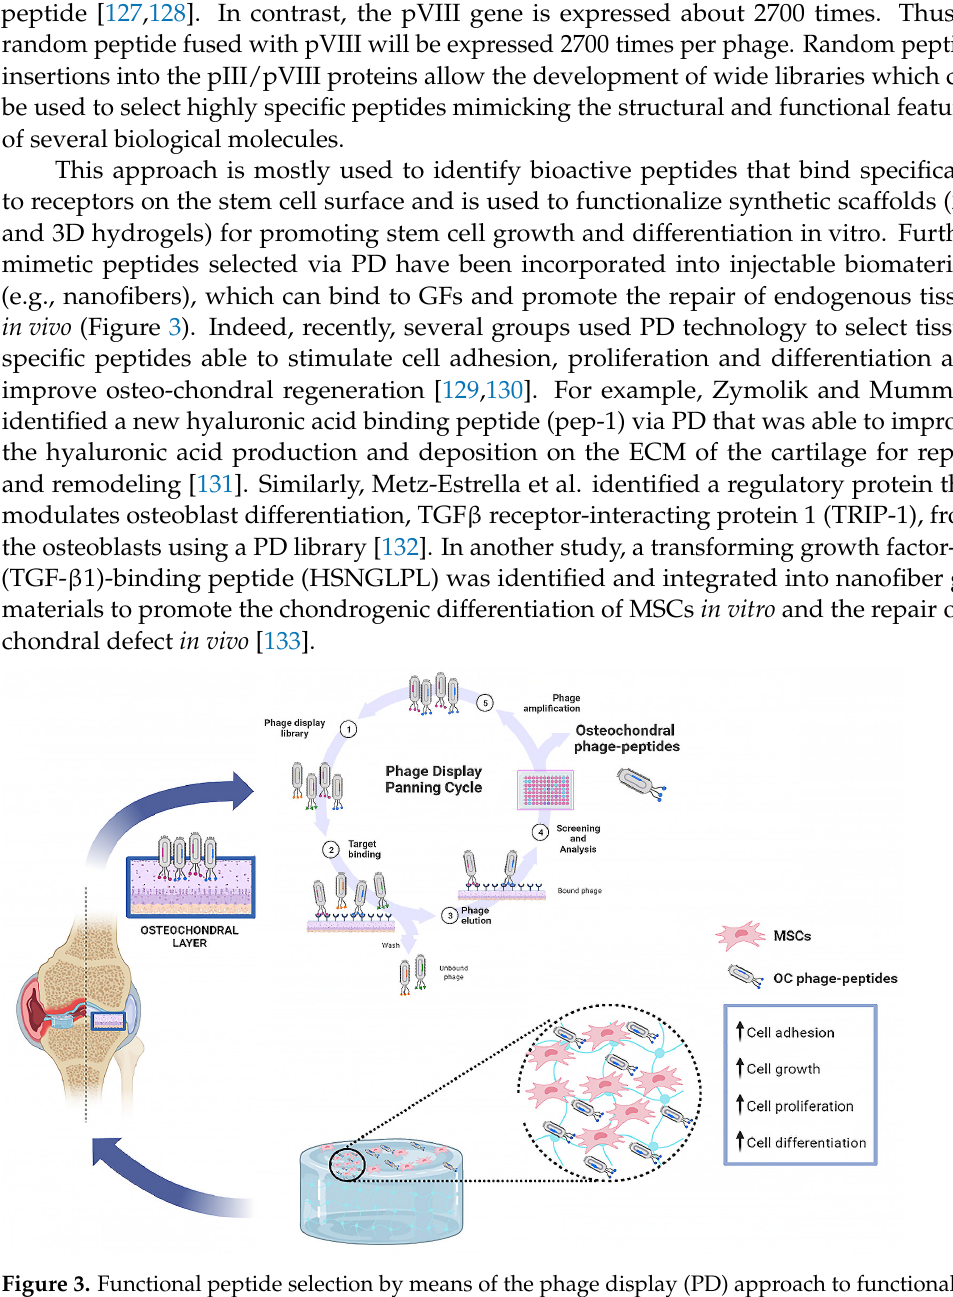
Figure 3. Functional peptide selection by means of the phage display (PD) approach to functionalize biomimetic scaffolds for OCTE. (1-5) Phage Display biopanning Cyclic representation. (1) Library construction; (2) Target capturing; (3) Elution of targets-specific phages; (4) screening and analysis; (5) Phage